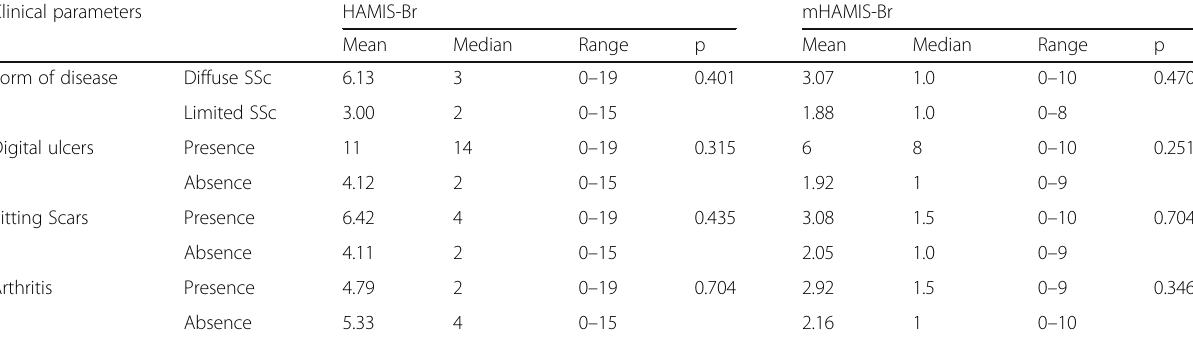
Table 4 Clinical parameters association test with HAMIS-Br and mHAMIS-Br Clinical parameters